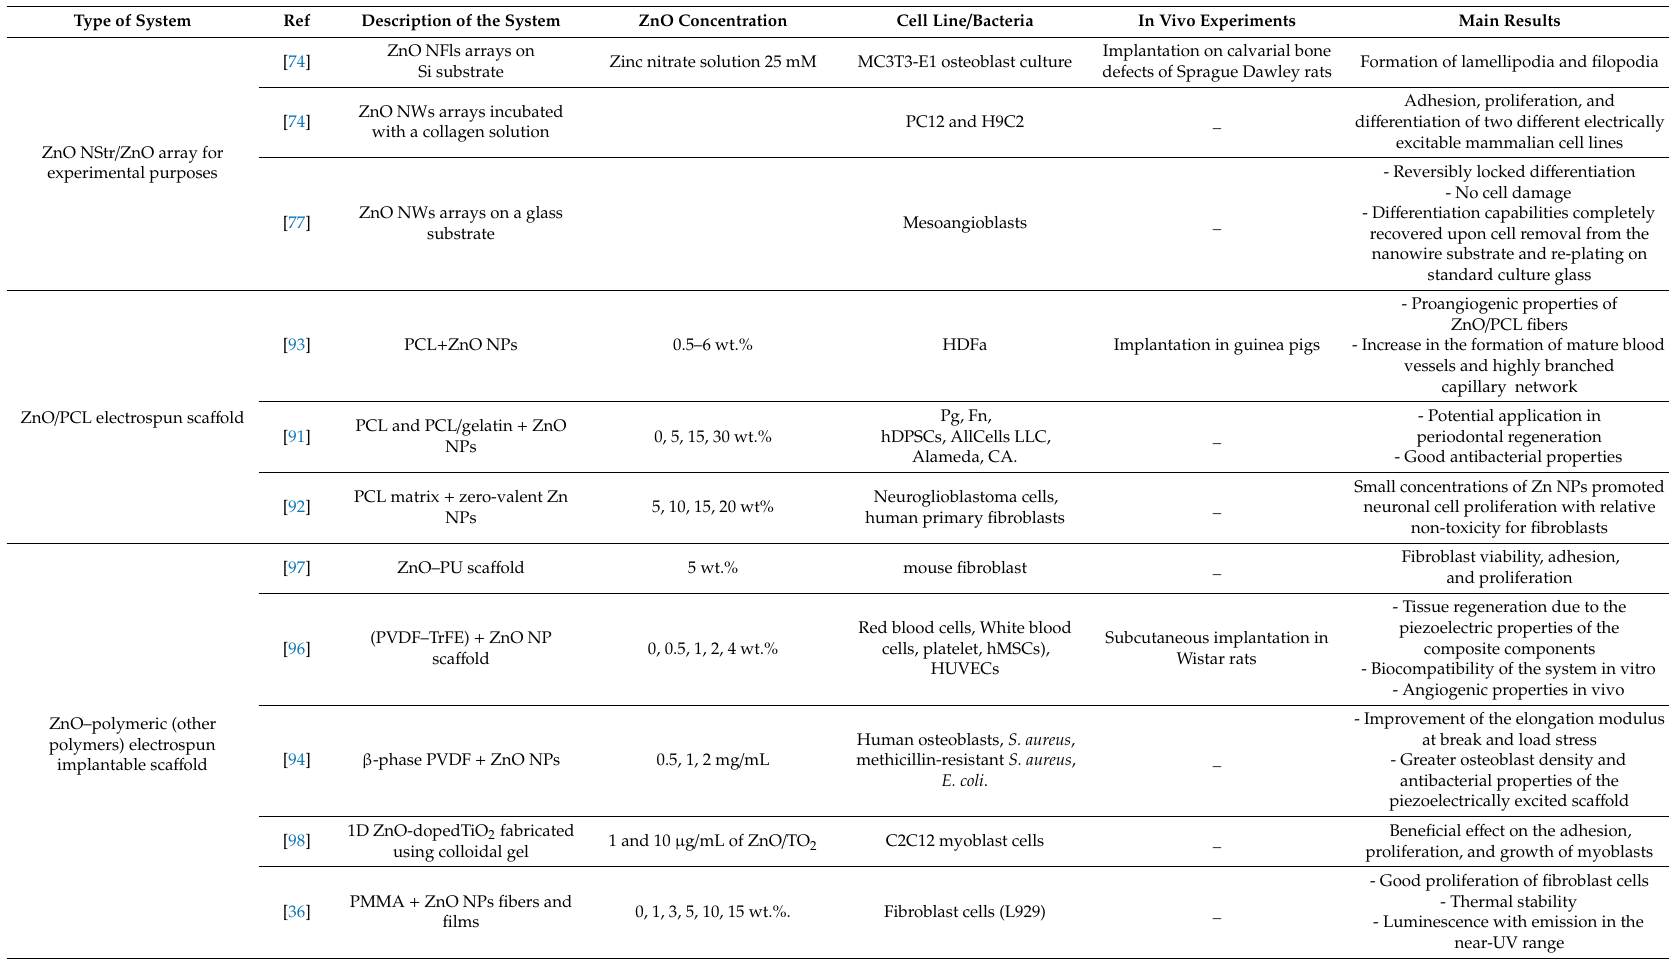
Table 2. Main results of recent studies on ZnO-based nanomaterials and electrospun ZnO–polymeric hybrid nanomaterials for tissue-engineering